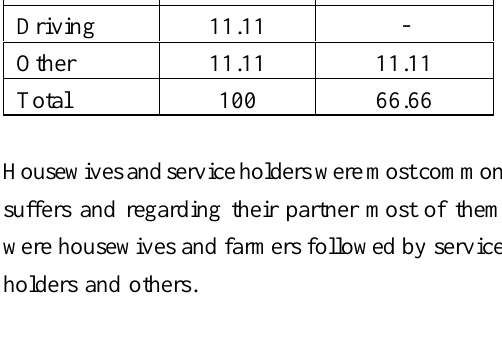
Table II: Patients' Complaints